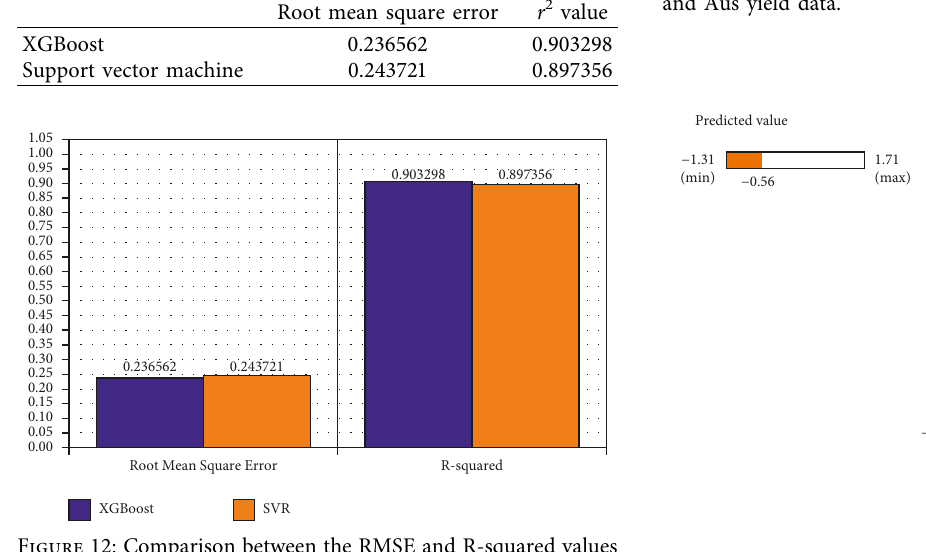
Figure 12: Comparison between the RMSE and R-squared values of XGBoost and SVR for Aus yield Prediction.